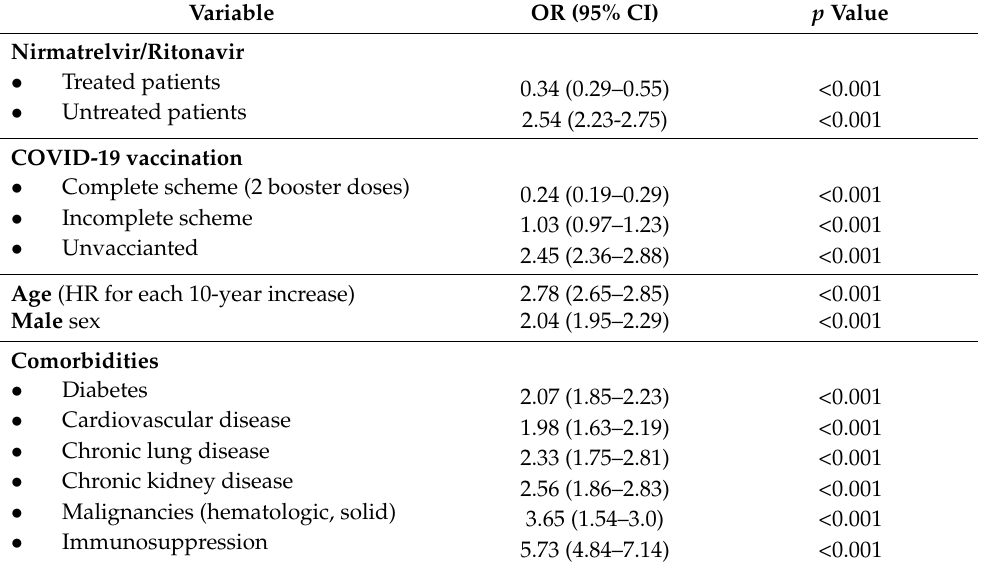
Table 4. Logistic Regression Analysis for Severe COVID-19 (Hospitalization, Intubation, Death) (n = 400, Group A and B).